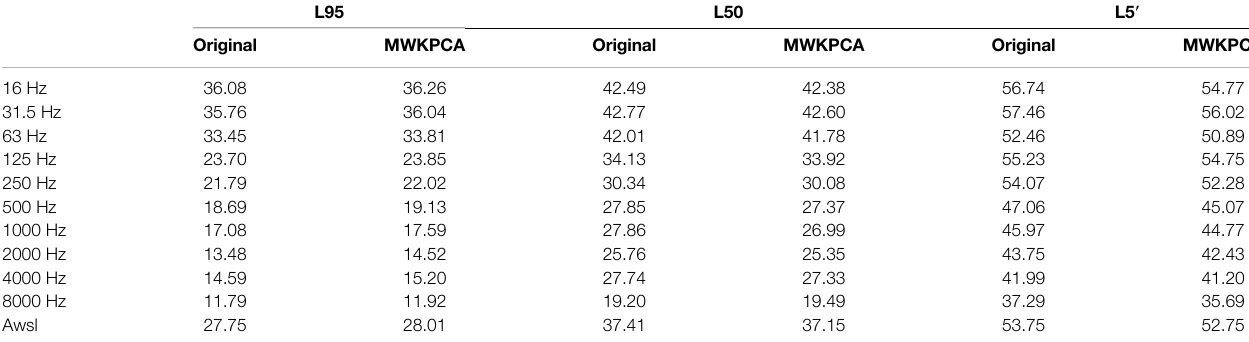
RMSE MAE MAPE SMAPE